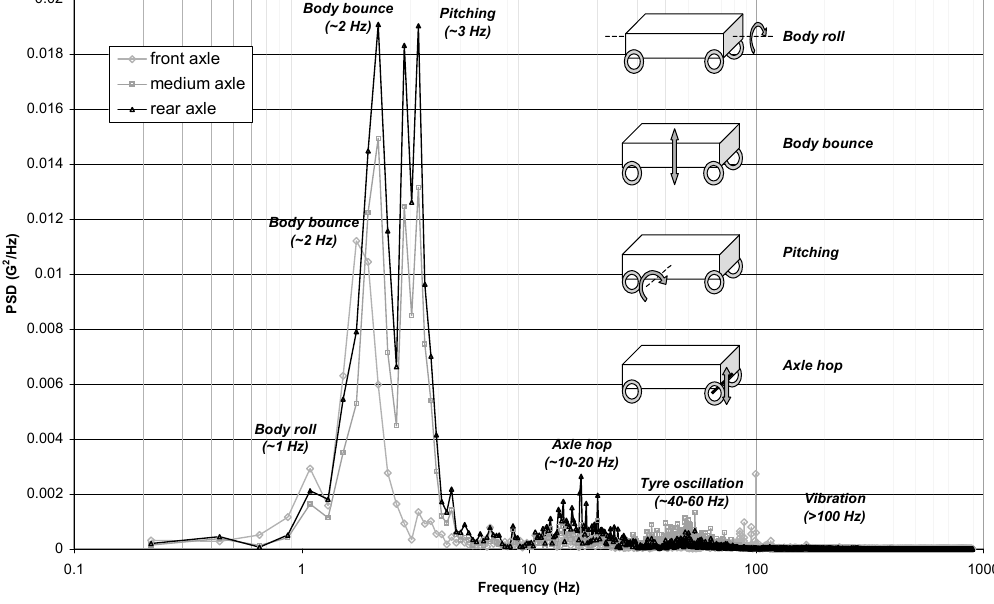
Figure 18. Power spectral density (for each axle, average value of the four tests with the 20 g accelerometer).